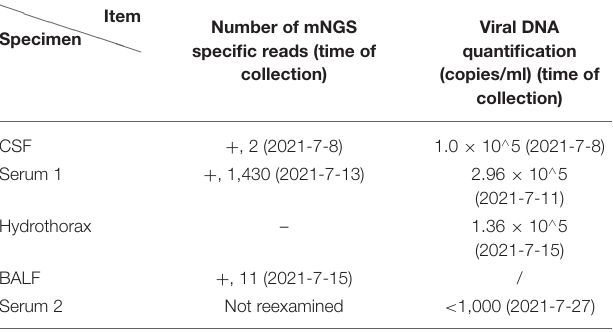
TABLE 1 | Test results of PV B19 in various body fluid samples of the patient. P P P P PP Specimen